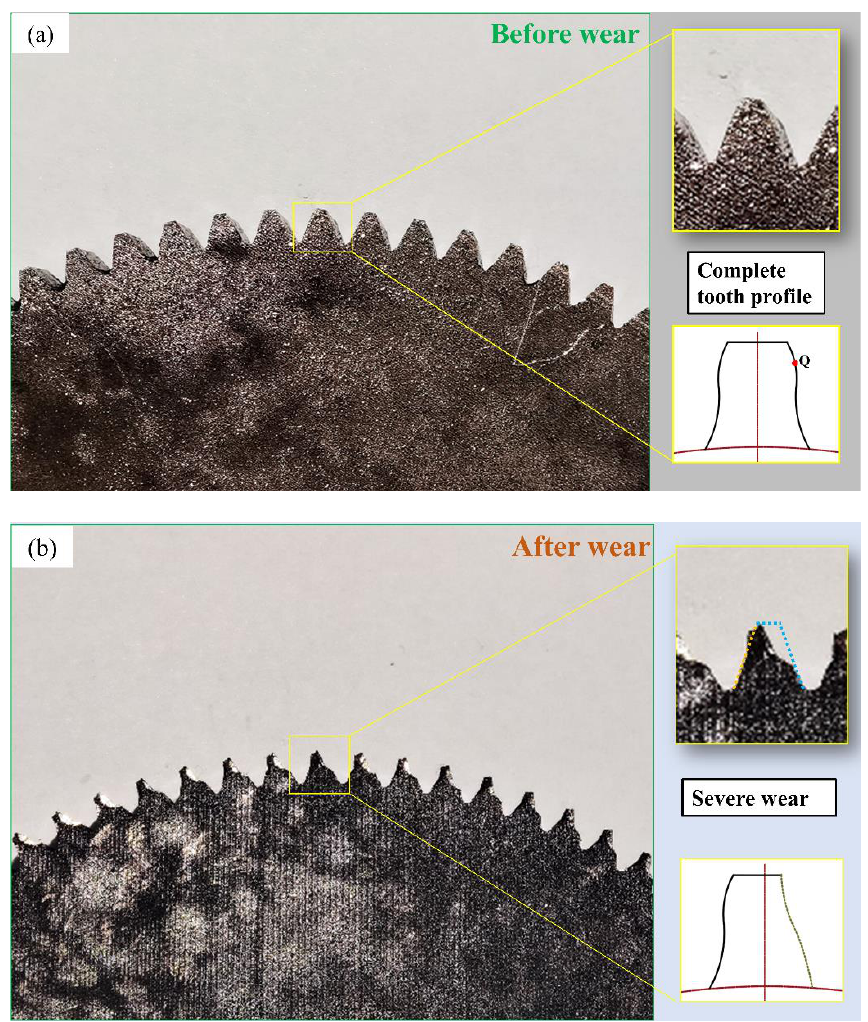
Figure 8. Tooth surface wear; ( a ) gear diagram before the experiment; ( b ) wear failure diagram of experimental gear.